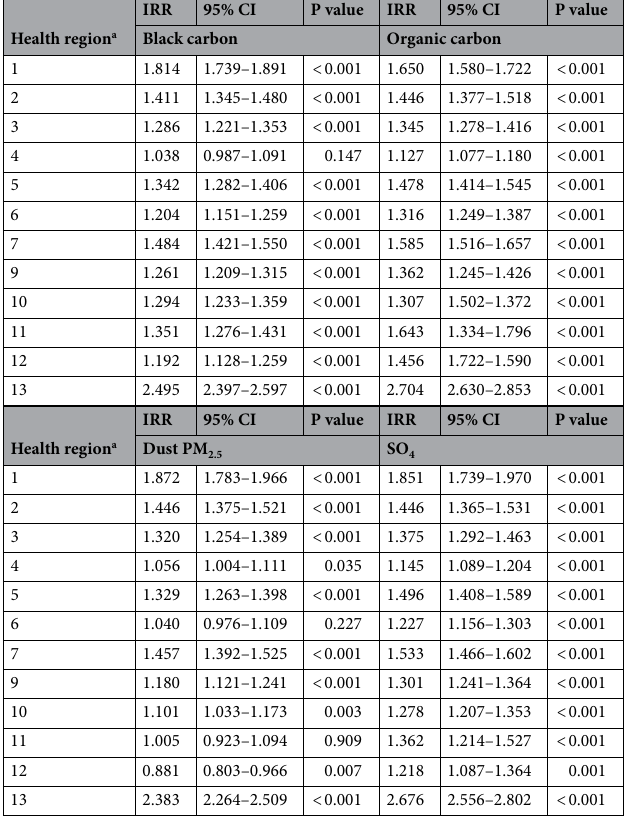
Table 2. Adjusted incidence rate ratio of colon cancer by the health regions. IRR incidence rate ratio, CI confidence interval. a Reference: health region-specific incidence rate ratio are all expressed in relation to the lowest incidence rate ratio area (the health region 8).